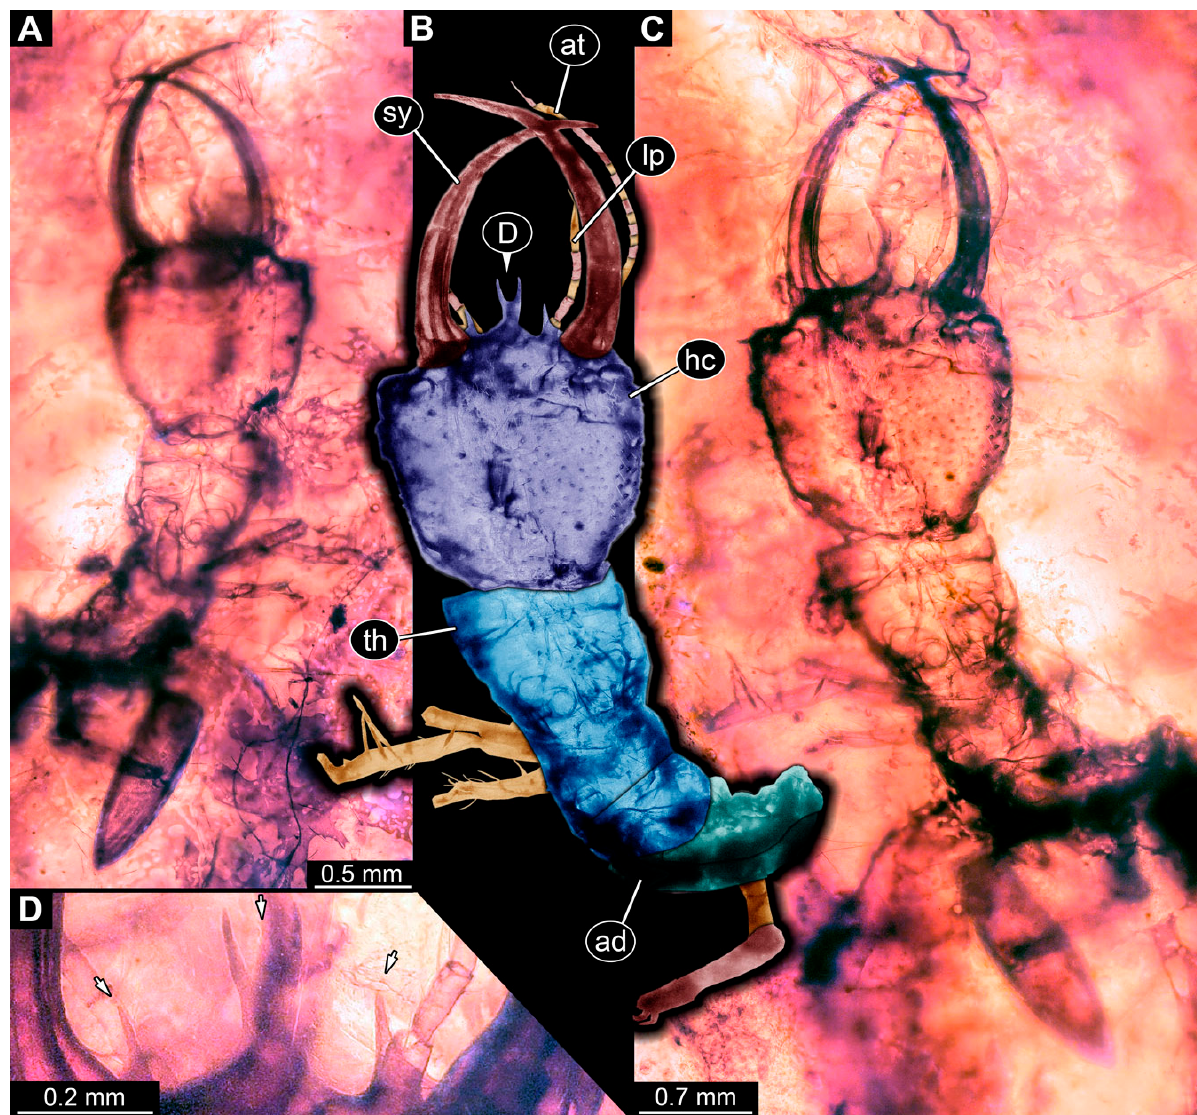
Figure 22. Specimen 86 (PED 1928); Myanmar amber. ( A ) Ventral view. ( B ) Dorsal view, colour- marked. ( C ) Dorsal view. ( D ) Close-up of labrum in dorsal view; arrows mark spine-like protru- sions. Abbreviations: ad = abdomen; at = antenna; hc = head capsule; lp = labial palp; sy = stylet; th =